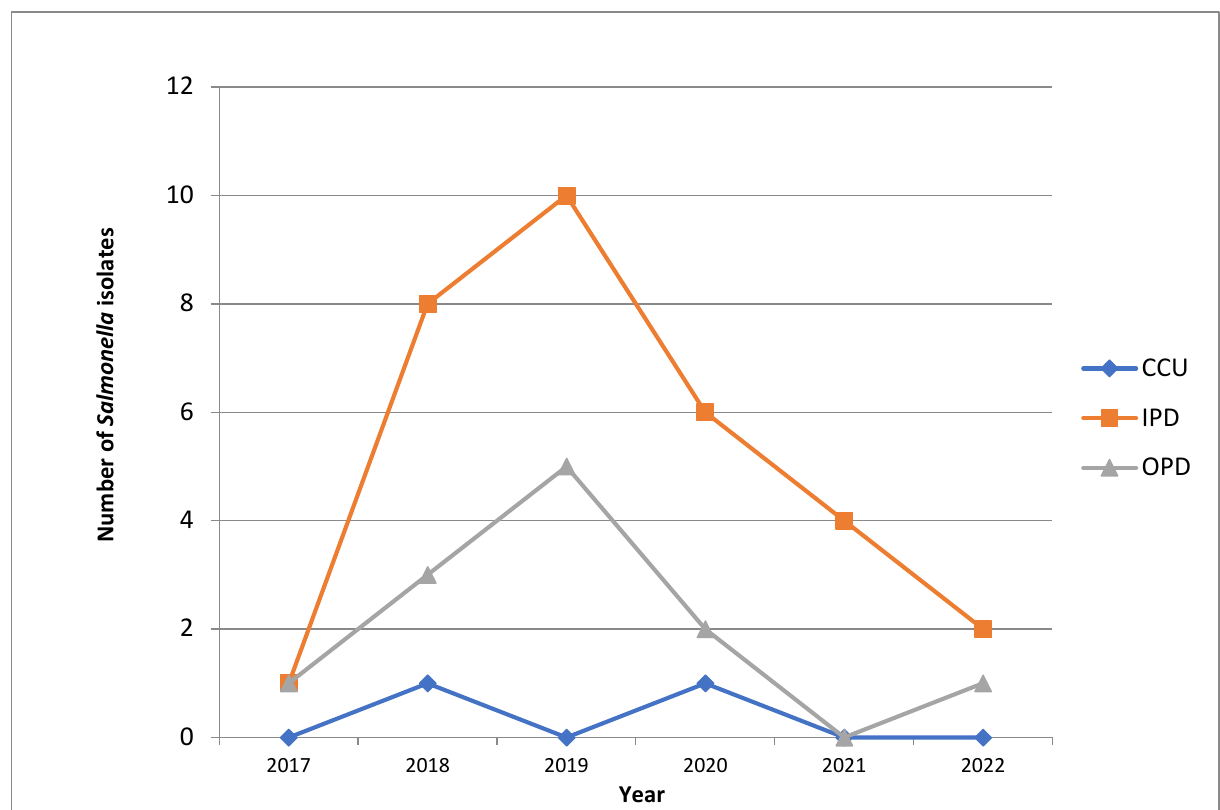
Figure 1. Line diagram showing the annual trends of obtaining Salmonella isolates from patients with enteric fever in the OPD, IPD and CCU. OPD: Outpatient Department, IPD: Inpatient Department, CCU: Critical Care Unit.